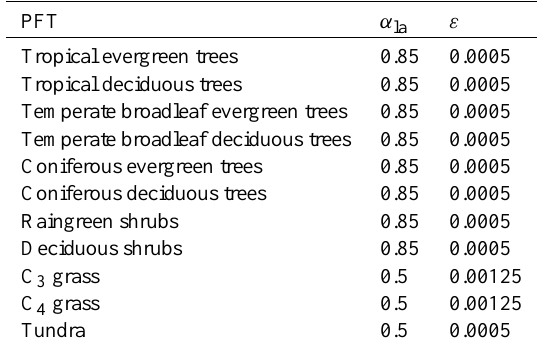
Table E1. PFT specific values of model parameters. See Parida (2010) for a detailed description.